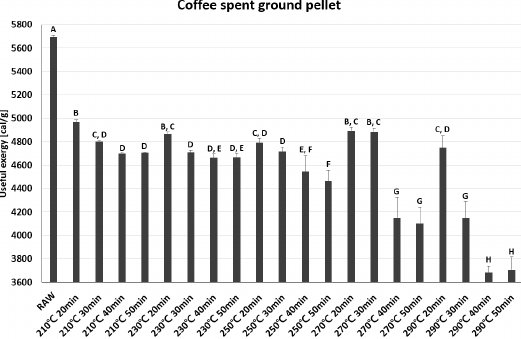
Figure 10. Useful exergy difference of each torrefied pellet.